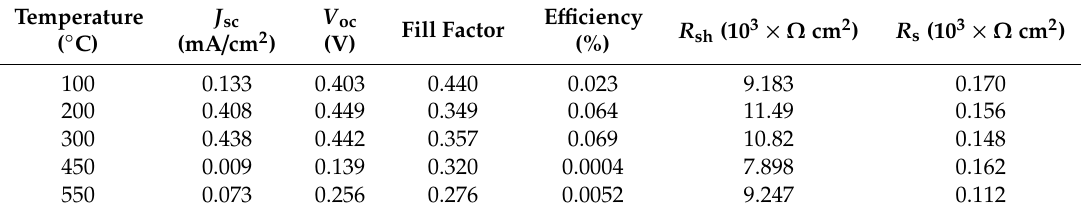
Figure 6. Current-voltage curve of annealed BiOI at di ff erent temperatures ( A ) and short-circuit current and open-circuit voltage as the function of temperature ( B ). Table 1. Photovoltaic cell parameter of annealed BiOI at di ff erent temperatures. J sc :